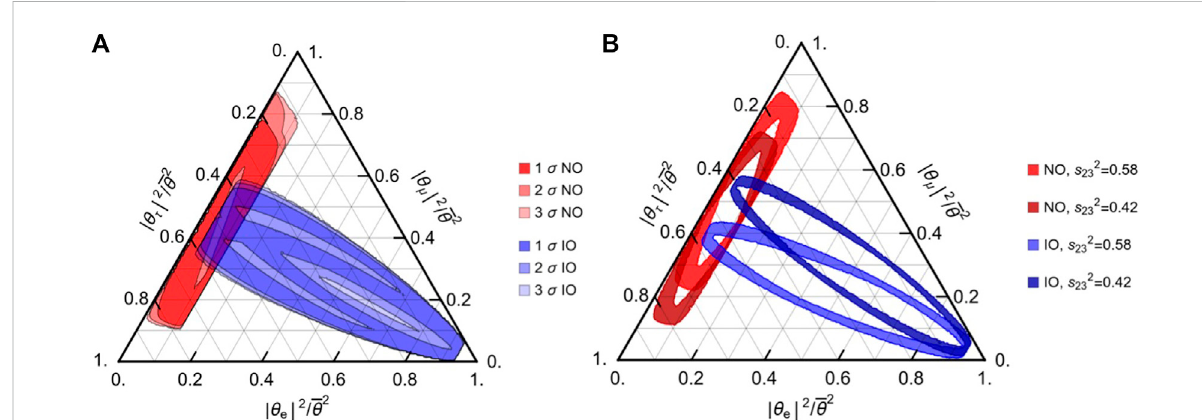
FIGURE 1 Allowed range for the relative magnitude of the HNL couplings to individual SM fl avors in the model (27) with n s =2, plot taken from [5]. (A) : The range ofrelative fl avor mixings ( (cid:4) i | V ℓ i | 2 )/( (cid:4) i , ℓ | V ℓ i | 2 )consistent with the current neutrino oscillation data, cf. e.g., [68, 69, 76]. The contourscorrespond to the allowed Δ χ 2 range taken from [77] for the case of normal (red) and inverted (blue) light neutrino mass ordering. (B) : The projected 90% CL contours for the relative mixings after 14 years of data taking at DUNE [78], assuming maximal CP violation δ = − π /2 and two benchmark values of the PMNS angle θ 23 , taken from the DUNE TDR [71], as indicated in the legend. FCC-ee can measure these ratios to the percent level in displaced HNL decays [44].